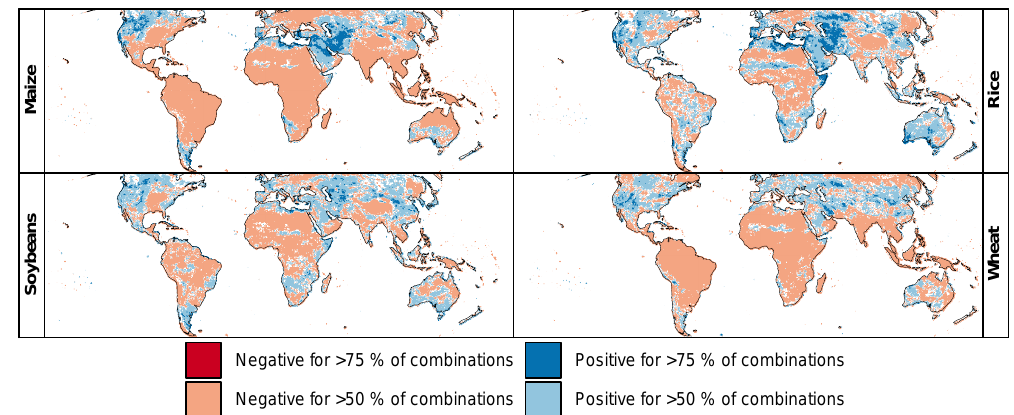
Figure 11. Percentage of crop model simulations (combination of a single GCM, GGCM, and RCP scenario) in the 2.5 ◦ C warming bin indicating an increase (blue) or decrease (red) in yield variance of greater than 5% compared to the historical period (1980–2010), for maize, rice, soy, and wheat under rain-fed conditions. White indicates either a change of less than 5% or disagreement among the models in the direction of change. Note that only four out of five GGCMs provided results for rice. An analogous figure for irrigated conditions is available in the